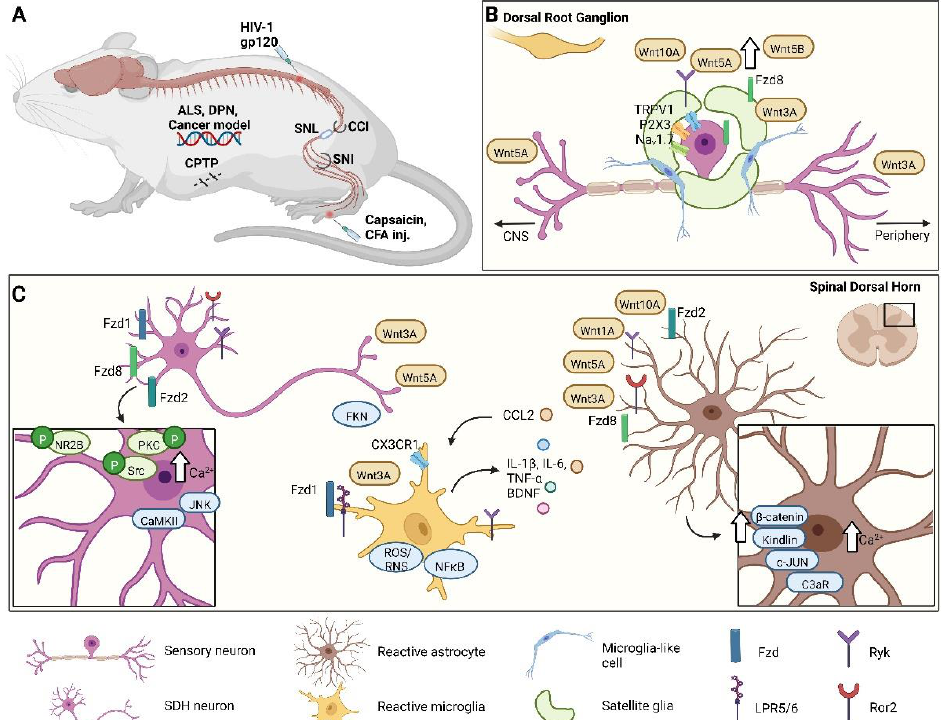
Figure 1. Wnt’s contributions to different pain conditions in various neuronal and non-neuronal cells. ( A ) Schematic representation of different pain models in mice. ( B ) After neuropathic pain induction, in dorsal root ganglia, activated nociceptors increase the receptors’ expression, such as TRPV1, P2X3, Na1.7, Ryk, and Fzd8, and that of Wnt-related proteins, e.g., Wnt5a, Wnt5b, Wnt3A, and Wnt10a. Likewise, in satellite cells, Fdz8 and Wnt3a are also overexpressed. ( C ) In the spinal dorsal horn, Wnt signaling is involved in pain sensation and acts on neuronal and non-neuronal cells. Many Fzd receptors and co-receptors (Ryk and Ror2) are upregulated in neurons, which brings about phosphorylation, activation of downstream targets (NR2B, Src, and PKC), and a Ca 2+ increase. This results in increases in JNK and CaMKII and the release of Wnt3a, Wnt5a, and FKN. Astrocytes harbor large amounts of Wnt proteins and receptors, which are upregulated during